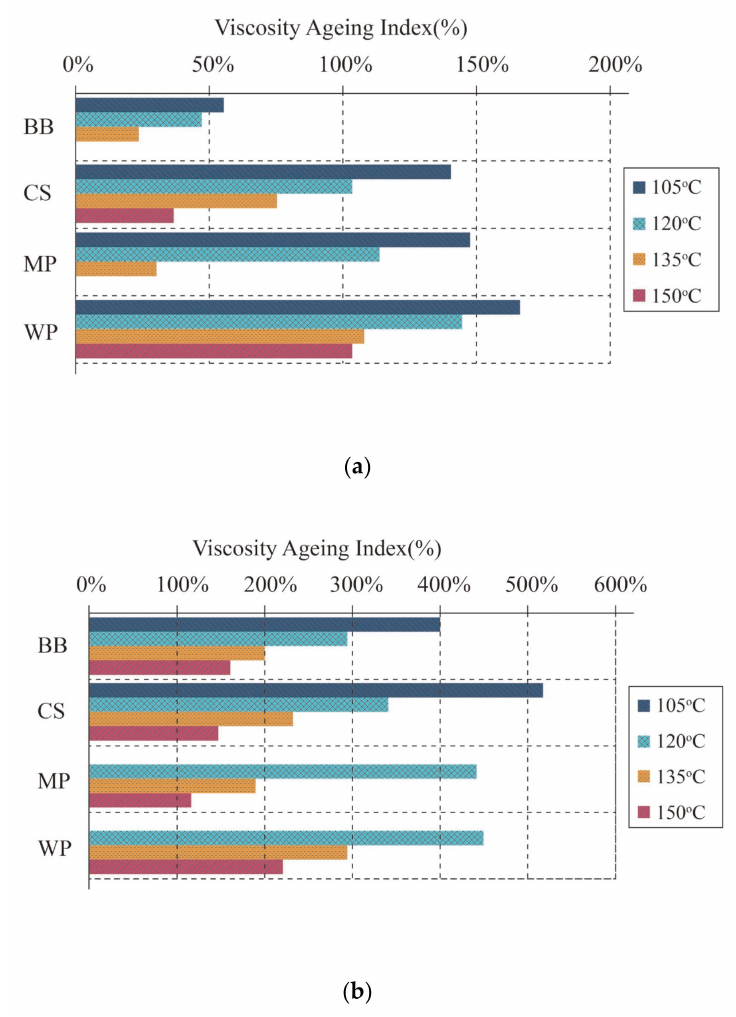
Figure 4. Viscosity ageing index of RTFO-aged and PAV-aged bio-oil modified asphalts: ( a ) RTFO- aged and ( b ) PAV-aged [8]. Note: BB refers to swine manure-based bio-asphalt; CS refers to corn stover-based bio-asphalt; MP refers to miscanthus pellets based bio-asphalt; WP refers to wood pellets-based bio-asphalt.